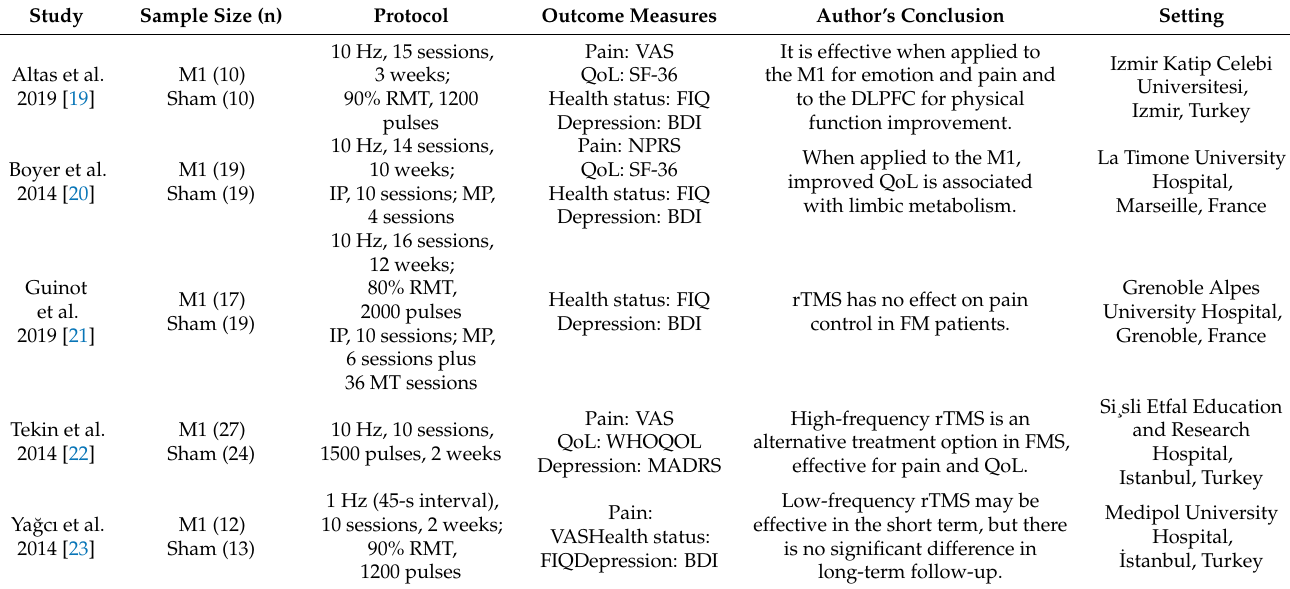
Table 1. Characteristics of included studies.